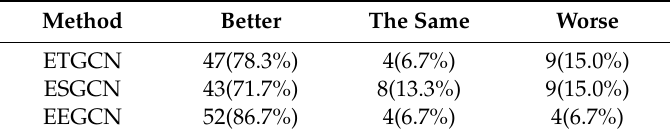
Table 3. The accuracy comparisons between ESGCN, ETGCN, EEGCN and AGCN [24]. Column 2 / 3 / 4 denotes how many classes of actions get better / the same / worse accuracies than AGCN [24]. Method Better The Same